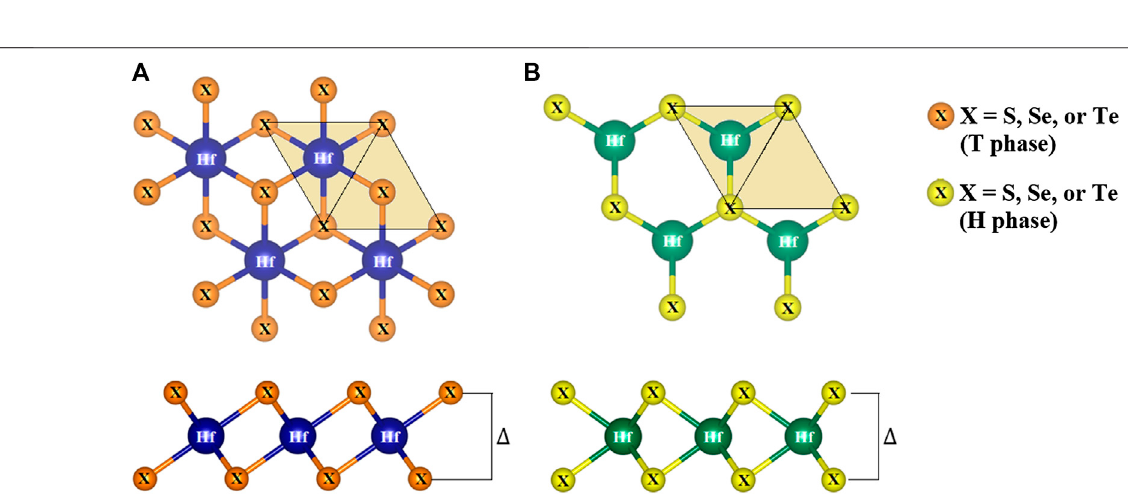
FIGURE 2 | The top (xy plane) and side (yz plane) views of HfX 2 (X (cid:1) S, Se, or Te) in the (A) T phase and (B) H